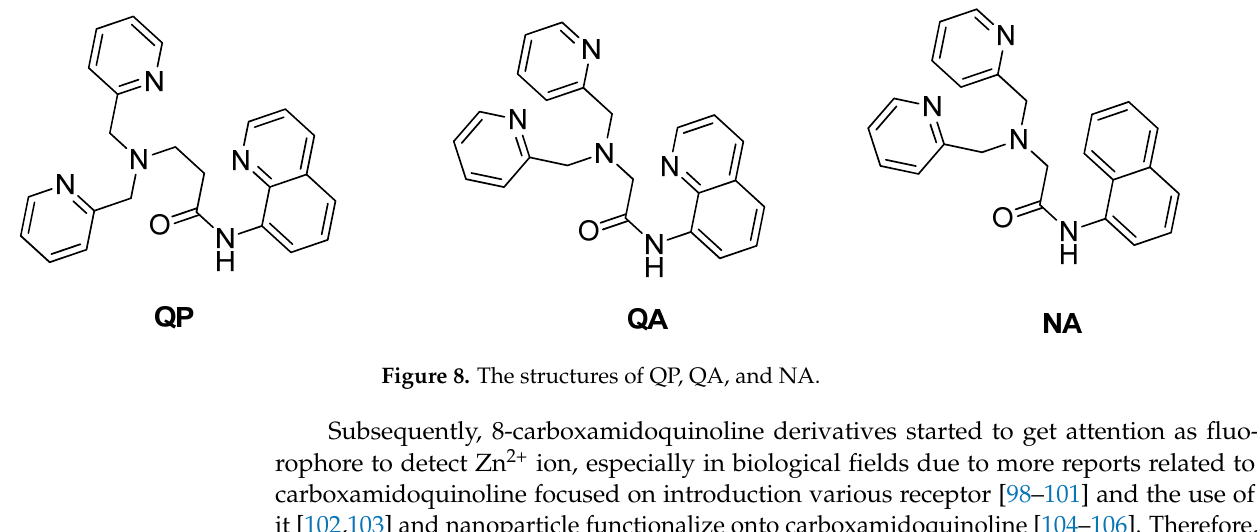
Figure 7. The carboxamidoquinoline-based AQZ family.